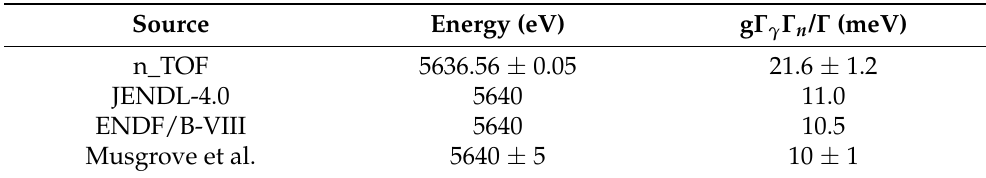
Figure 6. Example of the RSA in the case of p-wave resonance; in this case, the n_TOF fit (red) of the capture yield shows large discrepancies, compared to both the JENDL-4.0 (green) and ENDF/B-VIII (blue) libraries. Table 1. Capture kernel measured at n_TOF compared to the values reported by the ENDF/B-VIII and JENDL-4.0 libraries and by